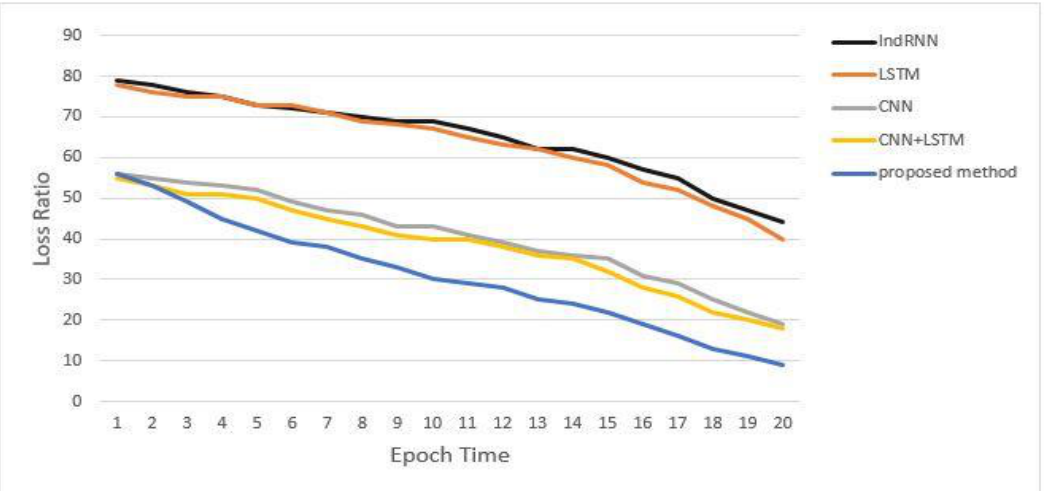
Figure 7. Loss ratio comparison of our proposed method with other different deep learning models.